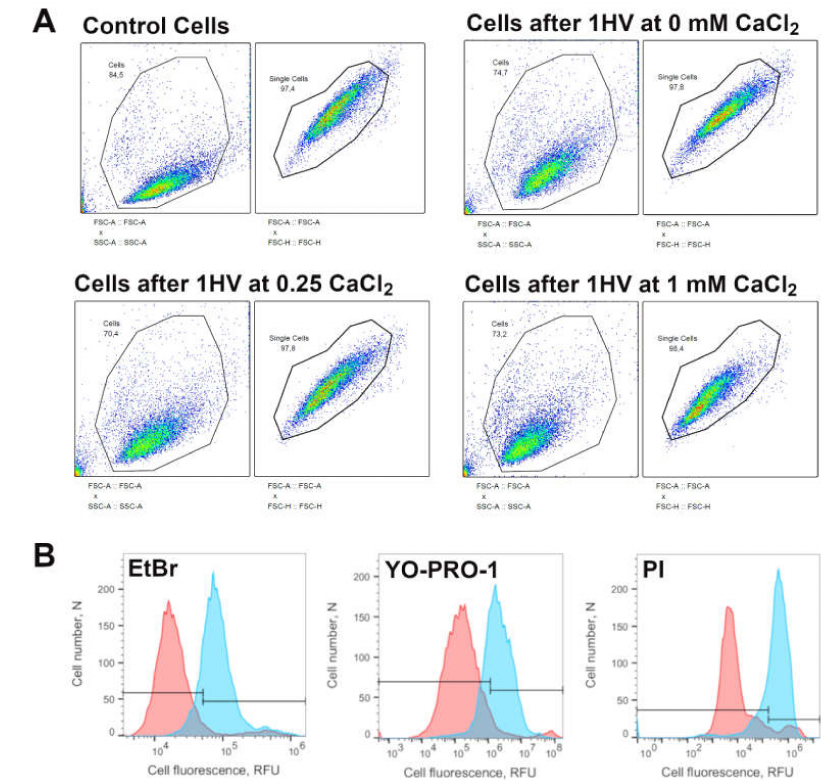
Figure 1. Flow cytometry gating strategies. Panel ( A ) represents cell distinction from the debris (FSC-A::SSC-A) and single cell (FSC-A::FSC-H) gating strategies. Panel ( B ) represents a gating strategy of cell fluorescence before (red) and 15 min after (blue) cell electroporation with HV pulse (1400 V / cm, 100 µ s) in the presence of EtBr, YO-PRO-1 and PI molecules in electroporation medium containing 1 mM of CaCl 2